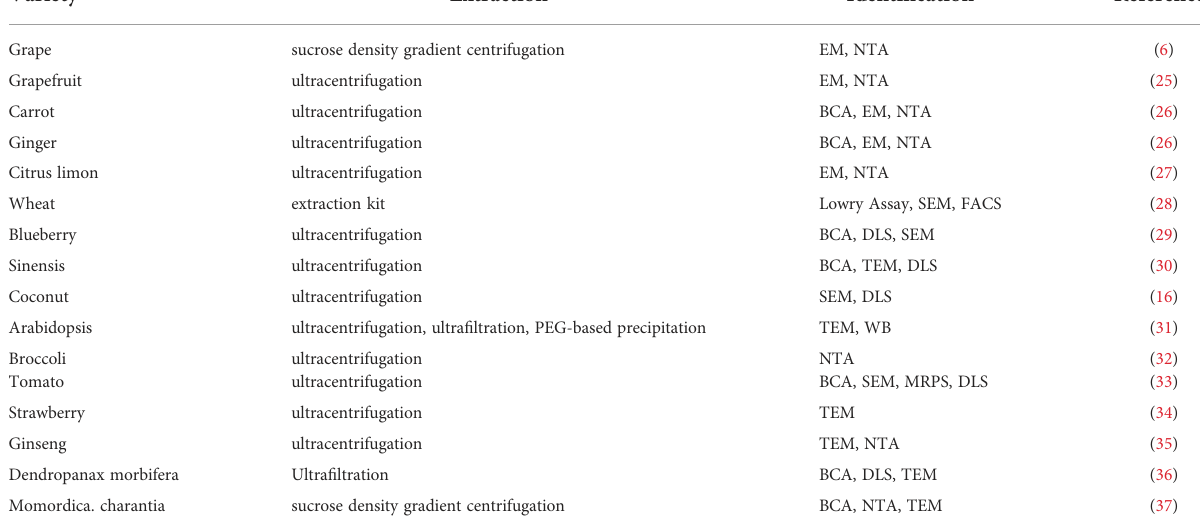
TABLE 1 Edible plant-derived